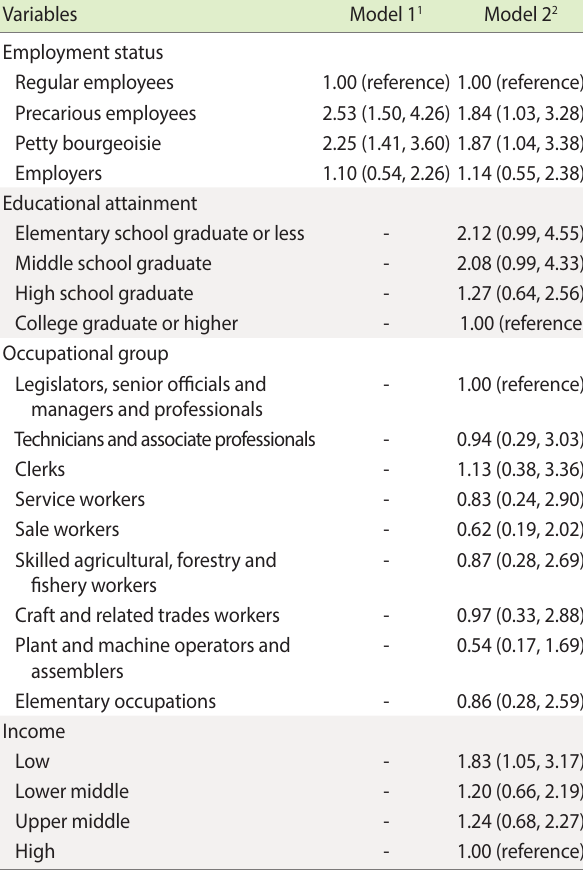
Table 3. Adjusted hazard ratios of mortality in 2000-2012 according Table 4. Mortality risk ratios in 2000-2012 according to the duration